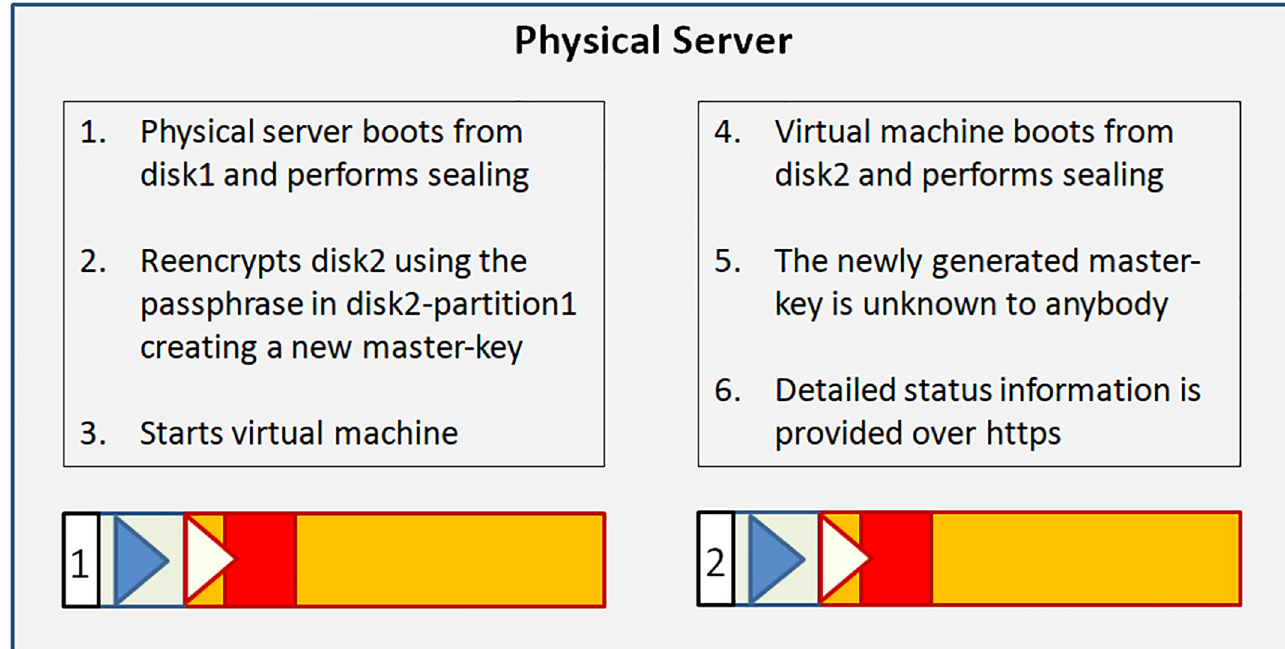
Fig 6. The complete Trusted Server with dual stage